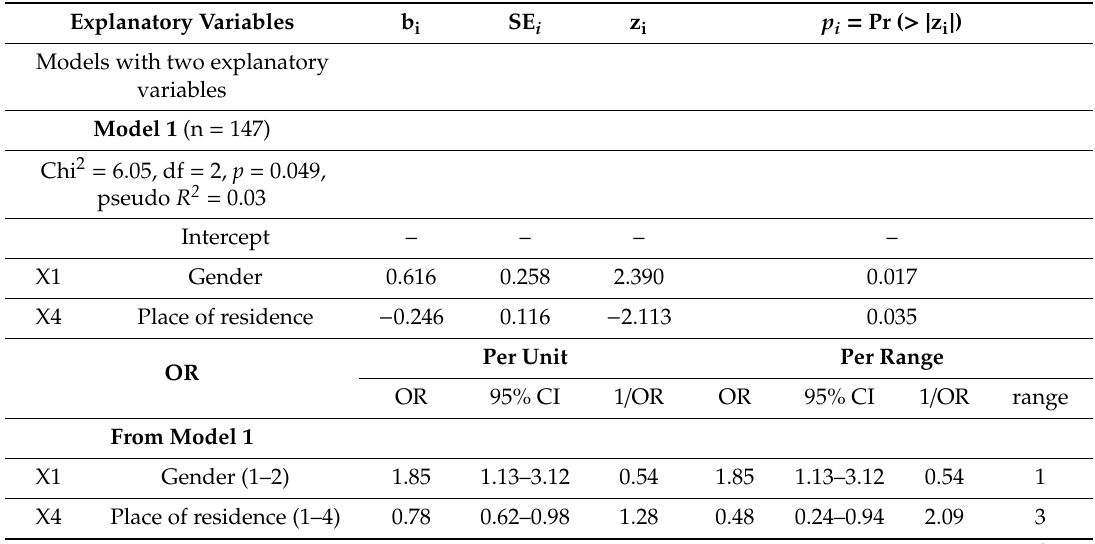
Table9. Resultsoflogisticregressionanalysisandtheoddsratioinlogisticregressionmodelincaregivers. Explained variable: Personal accomplishment (0—smaller, 1—bigger personal